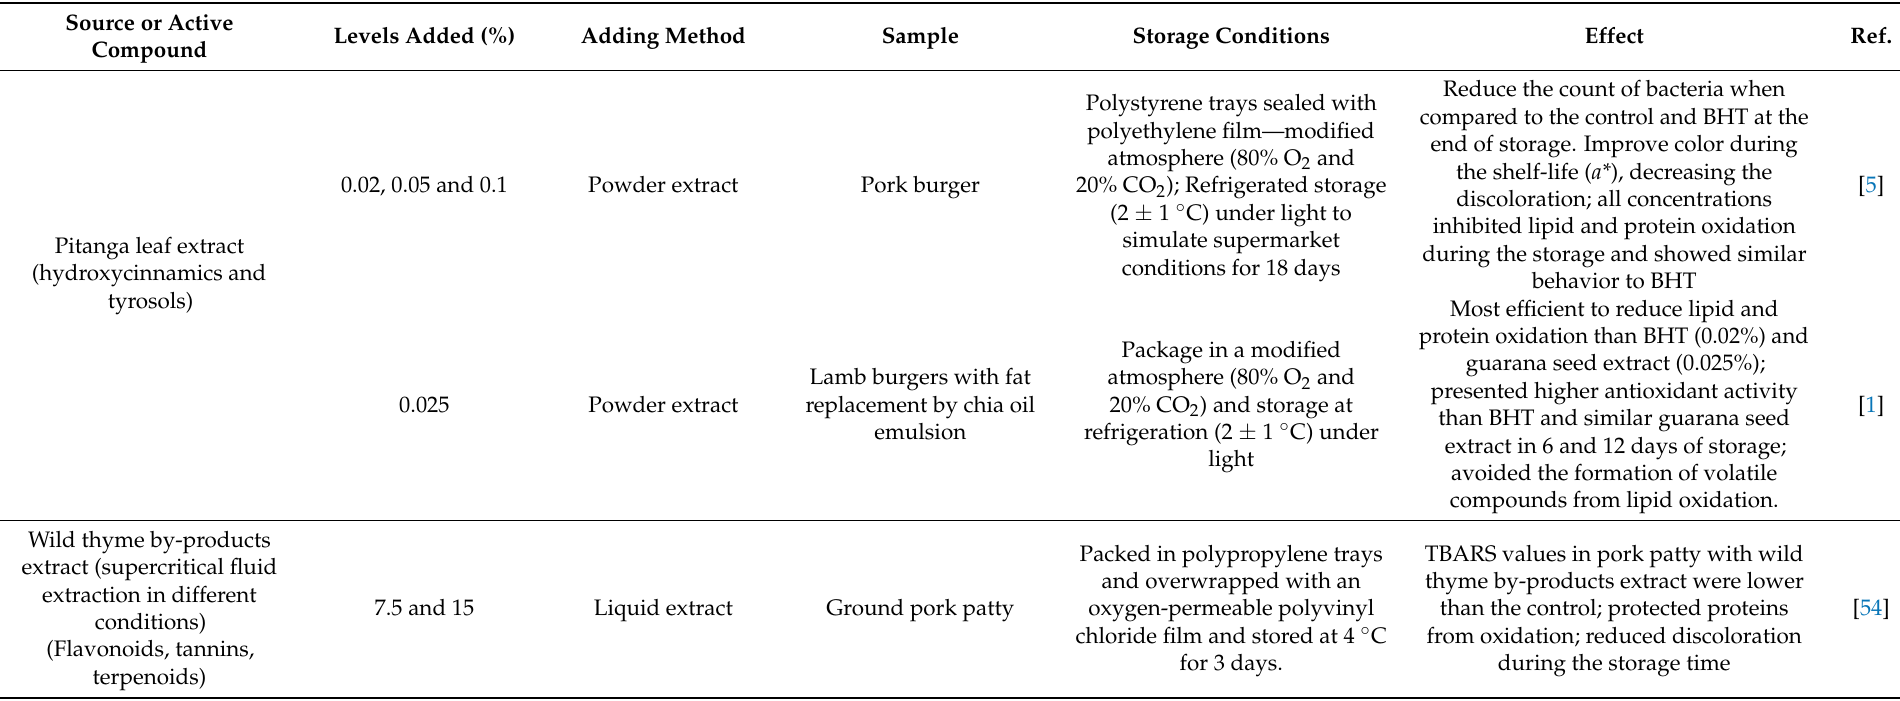
Table 3. Flowers, leaves, and vegetable residues as natural sources of antioxidants applied in meat